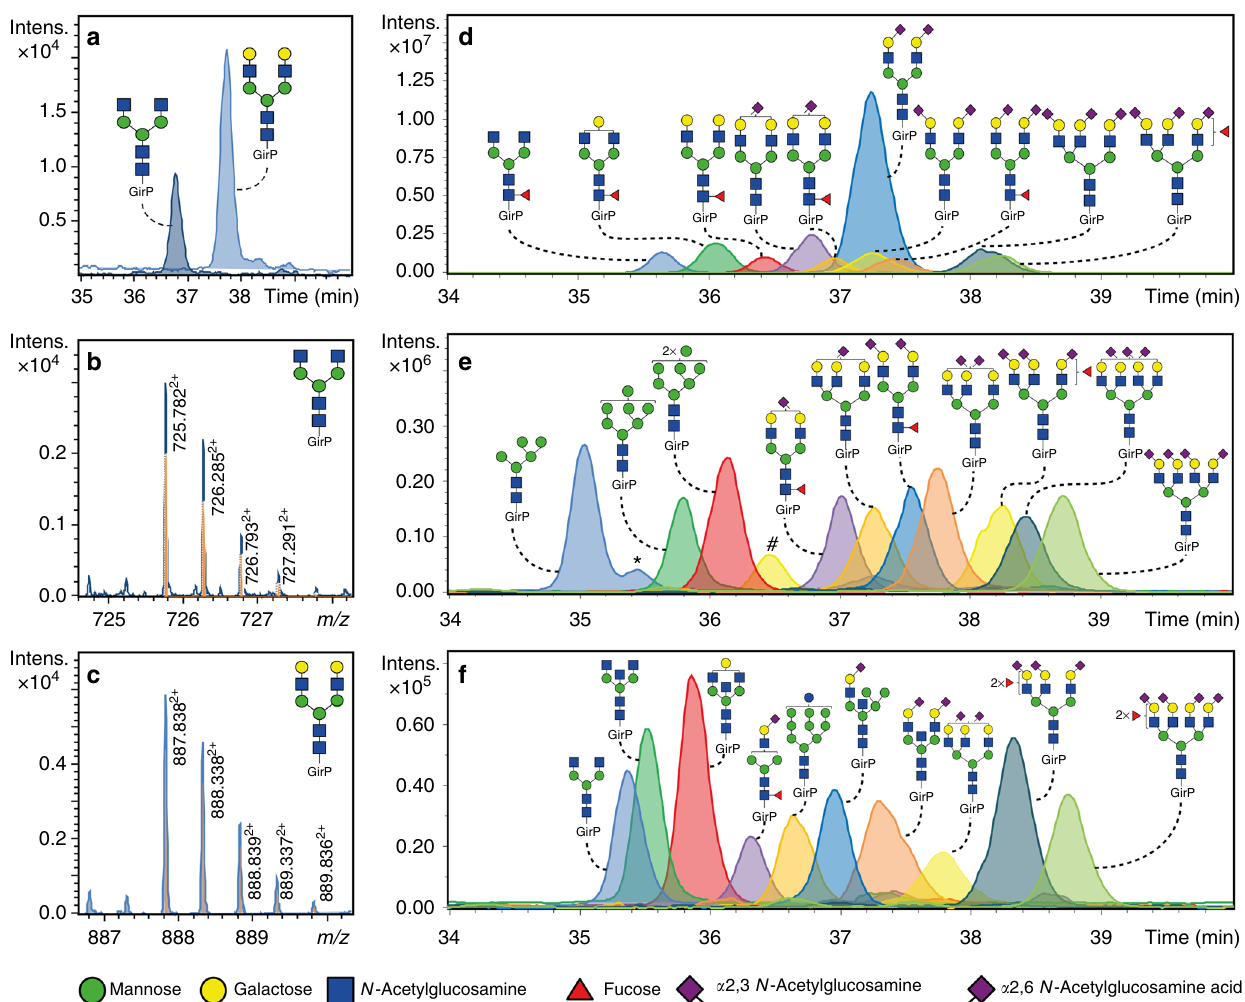
Fig. 2 Extracted ion electropherograms of derivatized and labelled N -glycans. a Extracted ion electropherograms of two N -glycan standards (H3N4 and H5N4) after injection of a fi nal amount of 20 amol. b , c Illustration of the obtained isotopic pattern and mass accuracy (blue trace) for the doubly charged species H3N4 and H5N4 compared with the theoretical isotopic pattern (orange trace). d Extracted ion electropherograms of the 10 most abundant N -glycans (>2% relative abundance) present in TPNG, e 10 medium abundant N -glycans (between 0.5 – 1.0% relative abundance) and f 10 low abundant N -glycans (<0.25% relative abundance). Separation was achieved using a bare-fused silica capillary after a dynamic neutral coating. *Indicates in-source decay of the H6N2. # Shows the presence of doubly charged species of H5N5F1 of which the m / z values overlap with the ones of the triply charged species of H6N5F1S 2,3 2S 2,6 1. Blue square: N -acetylglucosamine, green circle: mannose, yellow circle: galactose, red triangle: fucose, right pointing pink diamond: α 2,6-linked N -acetylneuraminic acid, left pointing pink diamond: α 2,3-linked N -acetylneuraminic acid, GirP: Girard ’ s reagent P